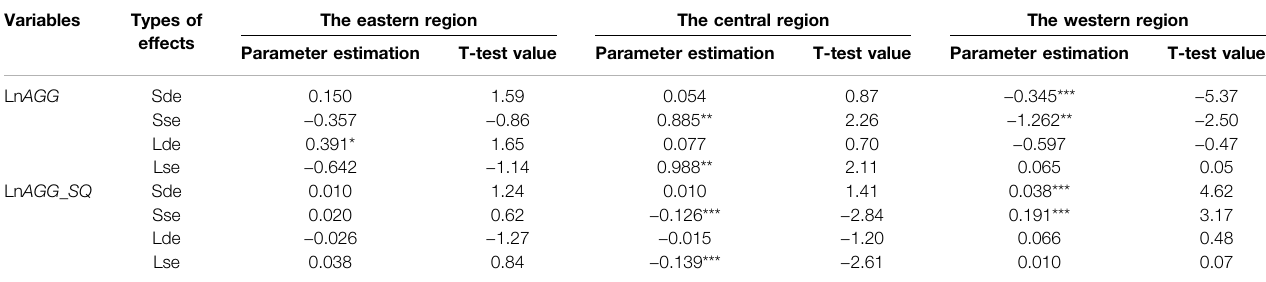
TABLE 8 | Estimated results of the agglomeration by region.